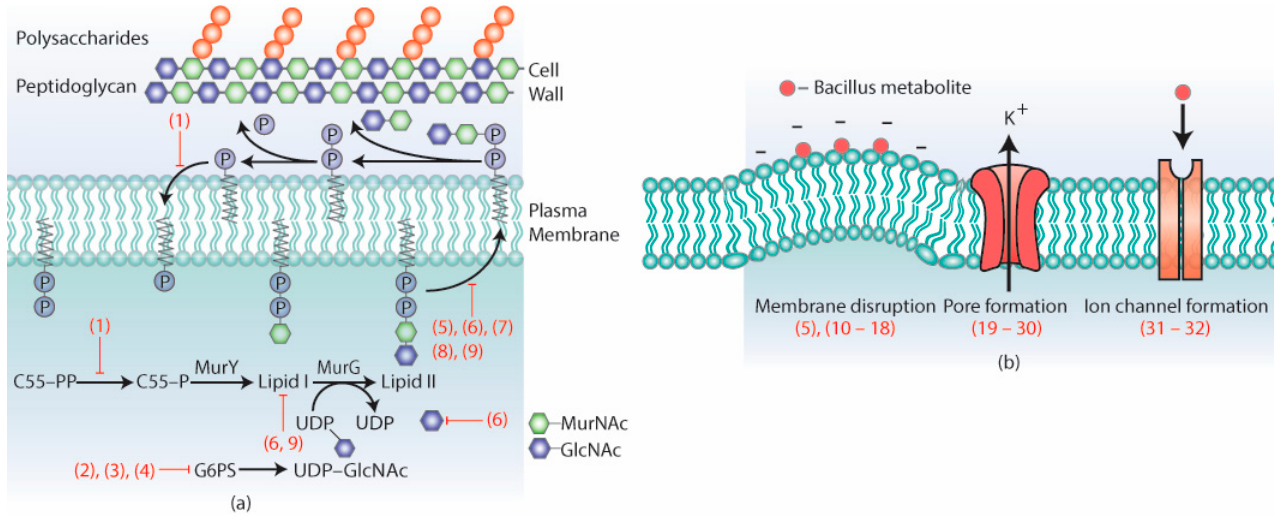
Figure 2. Metabolites targeting ( a ) cell wall and ( b ) plasma membrane .